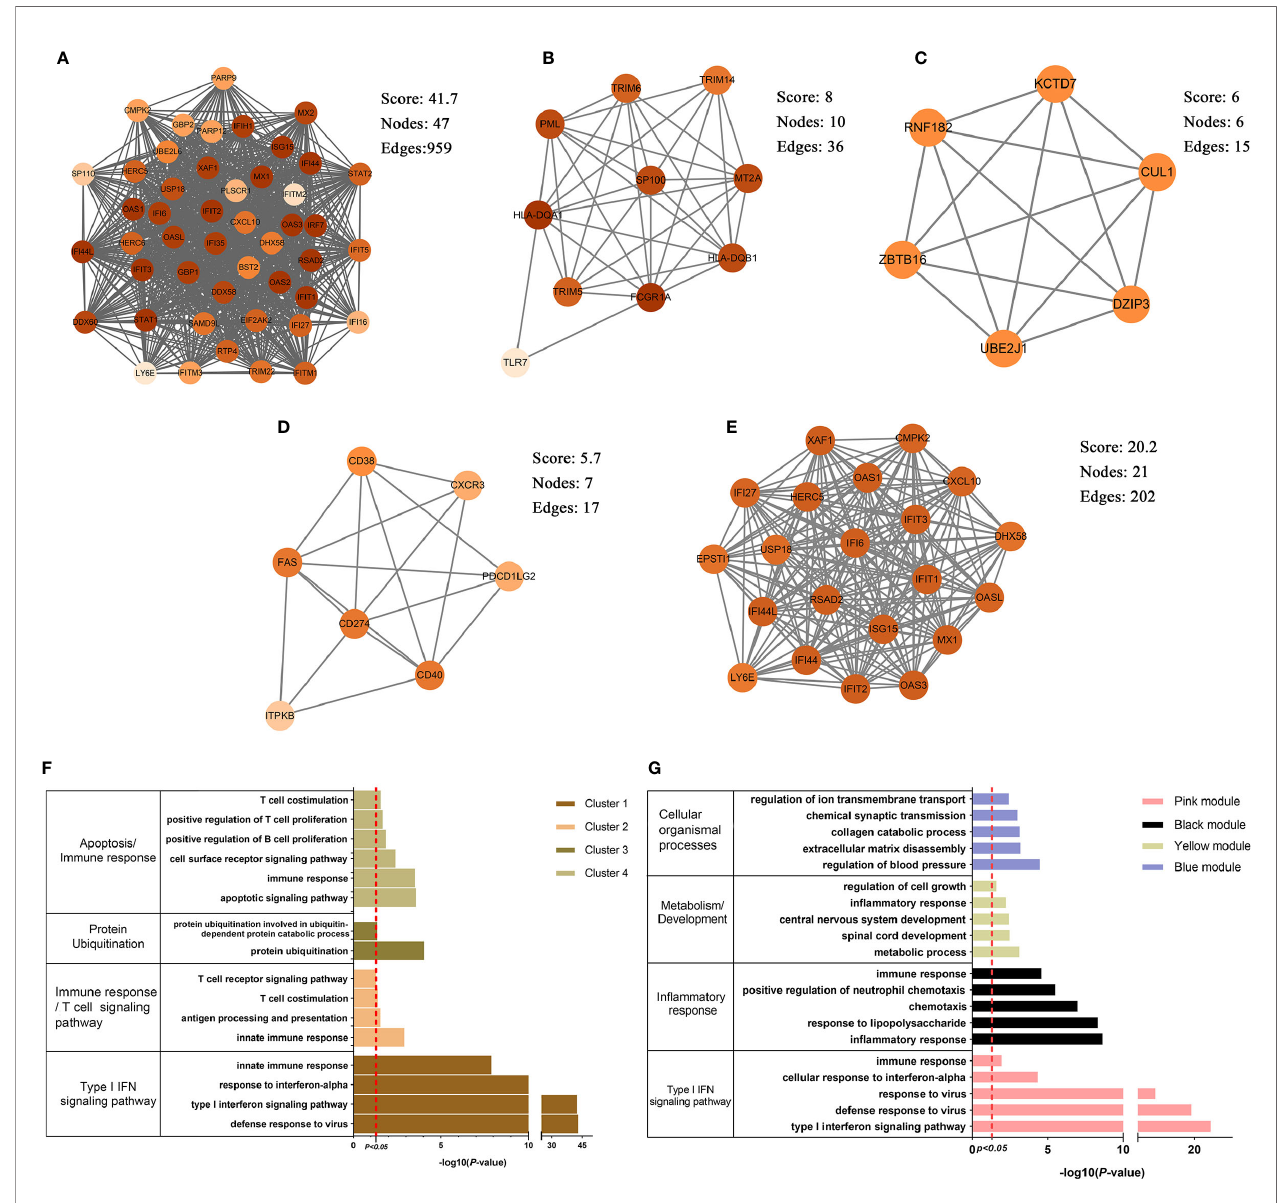
FIGURE 4 | The PPI network and clusters analysis. (A – D) The clusters 1 – 4 extracted from brown module in PAH. (E) The cluster extracted from the pink module in SLE. (F) The GO biological process analyses of four gene clusters in PAH, one or two key words were used to summarize their main biological functions. (G) The GO biological process analyses of four genes modules in SLE, one or two key words were used to summarize their main biological functions. PPI, protein – protein network; SLE, systemic lupus erythematosus; PAH, pulmonary arterial hypertension; GO, gene